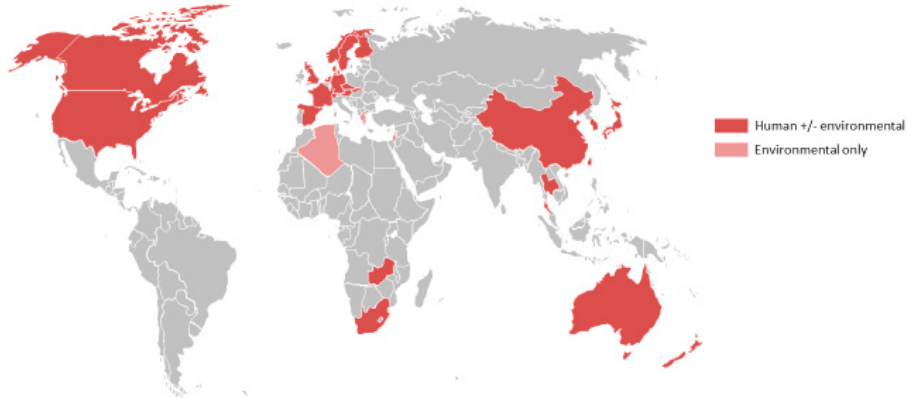
environmental sources [5,8–29]. Data from Austria, Norway and Slovakia provided by Figure 1. Reported global distribution of L. longbeachae isolated from human and/or environmental Julien Beaut é , European Centre for Disease Prevention and Control (ECDC); and for sources [5,8–29]. Data from Austria, Norway and Slovakia provided by Julien Beauté, European the Czech Republic by Vladimir Drašar, Head Public Health Institute Ostrava, National Centre for Disease Prevention and Control (ECDC); and for the Czech Republic by Vladimir Legionella Reference Laboratory, Czech Drašar, Head Public Health Institute Ostrava, National Legionella Reference Laboratory, Czech Republic.